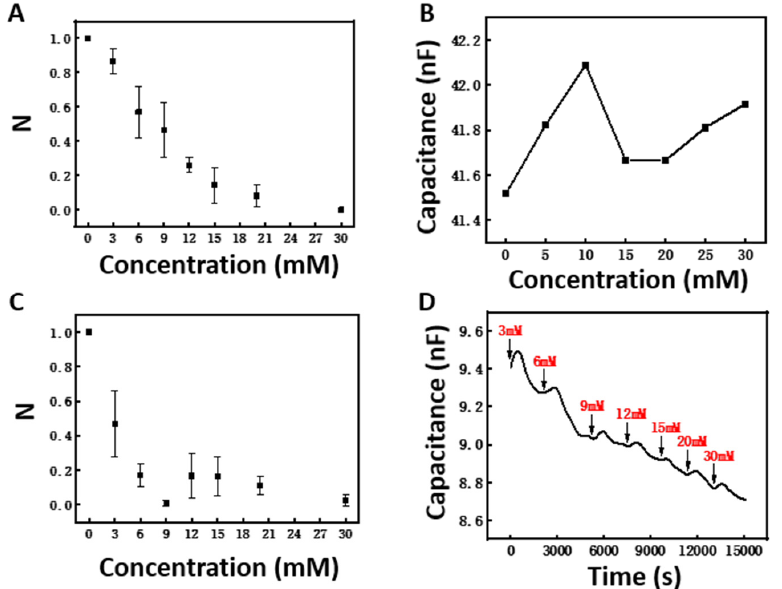
Figure 3. ( A ) Dependence of the capacitance of the capacitive glucose sensor on the glucose buffer solution (pH 7.4) with different concentrations at 30 kHz. ( B ) Dependence of the capacitance of the SRE without hydrogel integration on the glucose buffer solution (pH 7.4) with different concentrations at 30 kHz. ( C ) Dependence of the capacitance of the sensor without a semipermeable membrane on the glucose buffer solution (pH 7.4) with different concentrations at 30 kHz. ( D ) Continuous response curve of the capacitive glucose sensor at glucose concentrations ranging from 0 to 30 mM.